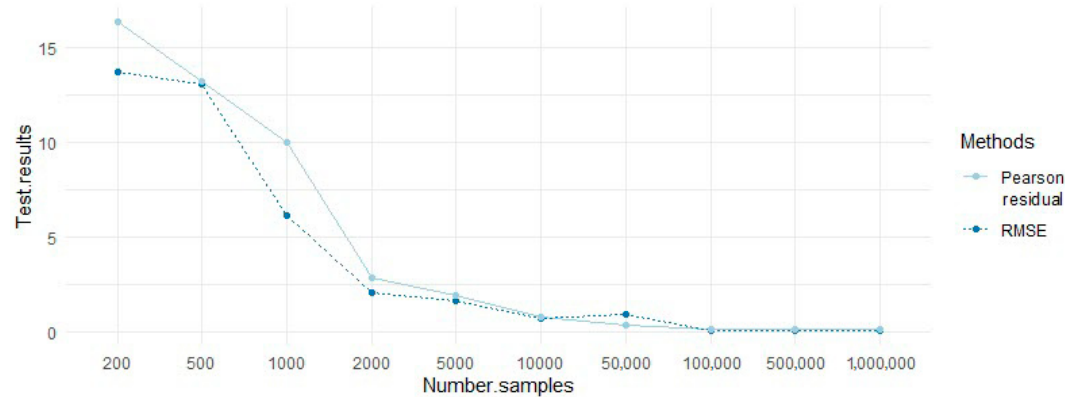
Figure 8. Comparison of the estimation accuracy of the posterior values for the model parameters with different sizes of samples.